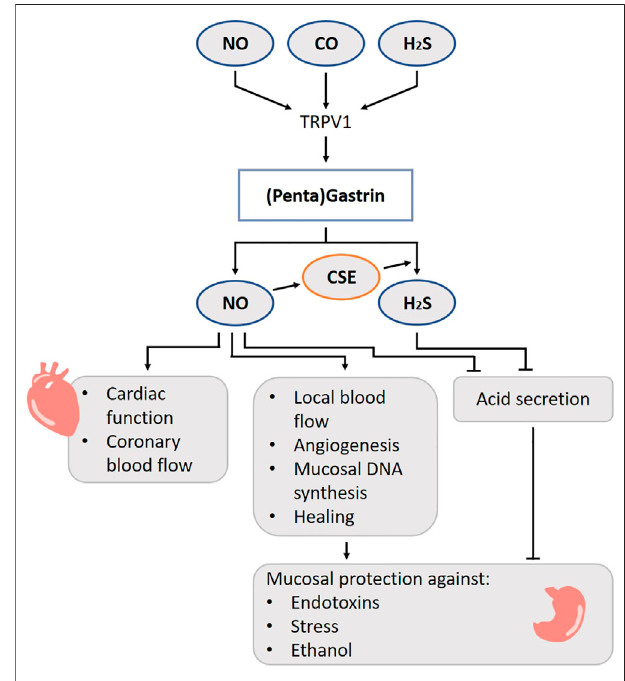
FIGURE 4 | Role of gasotransmitters on gastrin release and its physiological functions. Solid lines are clear evidence – based on blockers and substrate administration. Gaseous molecules may regulate gastrin release via TRPV1. There is a bene fi cial relation between NO and gastrin leading to hyperemia, increased local blood fl ow, angiogenesis, mucosal DNA synthesis and increased healing. NO and H 2 S governs the gastric acid output. Taken all together, gastrin performs a stomach protecting function via gasotransmitters. NO, Nitric oxide; CO, Carbon monoxide; H 2 S, Hydrogen sul fi de; TRPV1, Transient receptor potential vanilloid subtype 1; CSE, Cystathionine gamma-lyase.